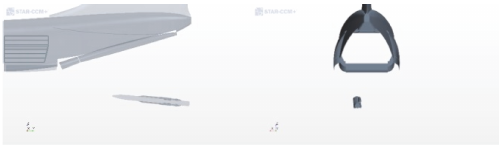
Figure 24: Lateral velocity curve.